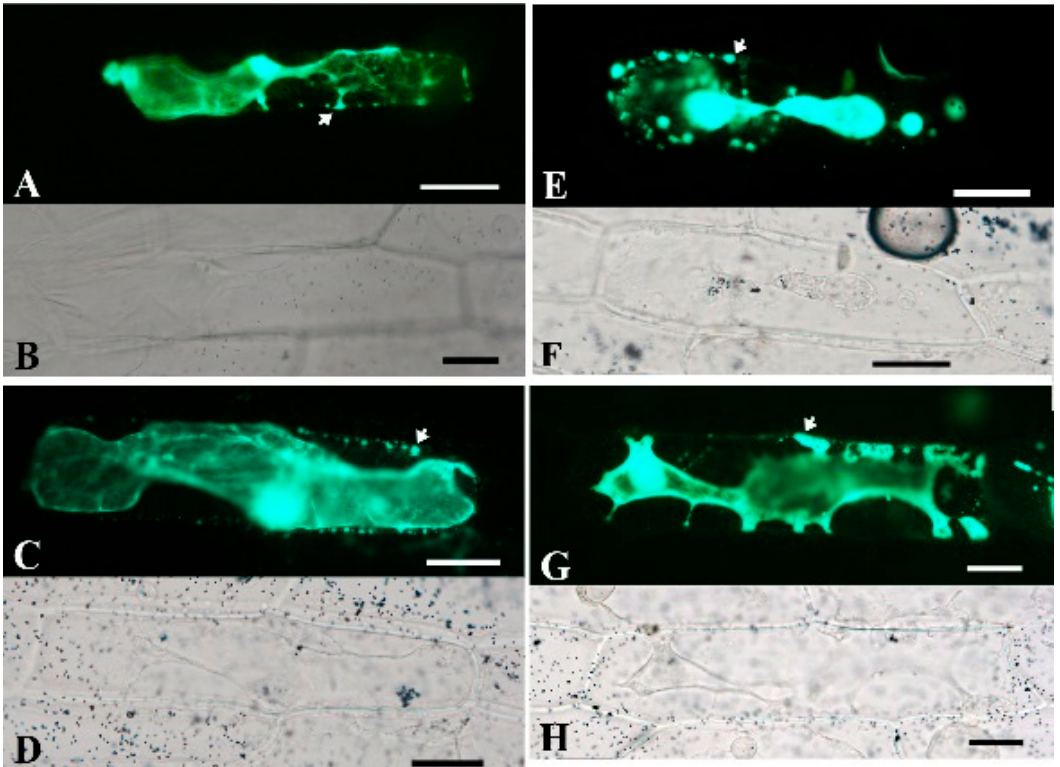
Figure 7. Subcellular localization of four BoPG-green fluorescent protein (GFP) fusion proteins in onion epidermal cells. ( A , E , C , and G ) show fluorescence images of plasmolyzed transgenic cells. The fluorescence signal can be observed in the cell wall (white arrows). ( B , F , D , and H ) are bright-field images of the corresponding onion epidermal cells. Scale bars = 50 µ